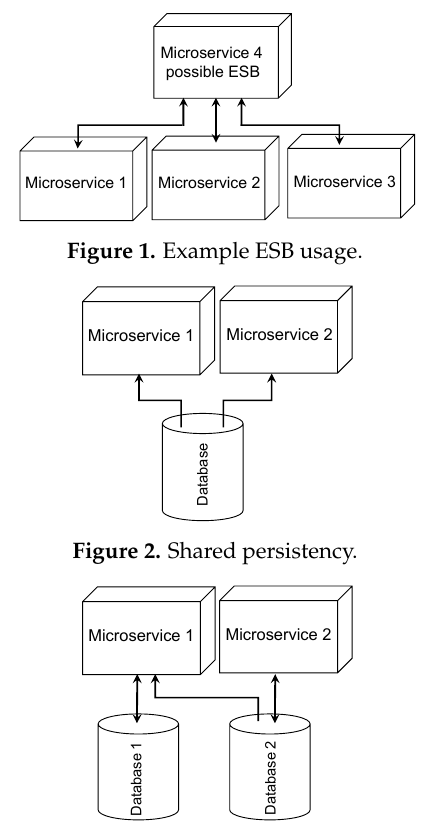
Figure 3. Inappropriate service